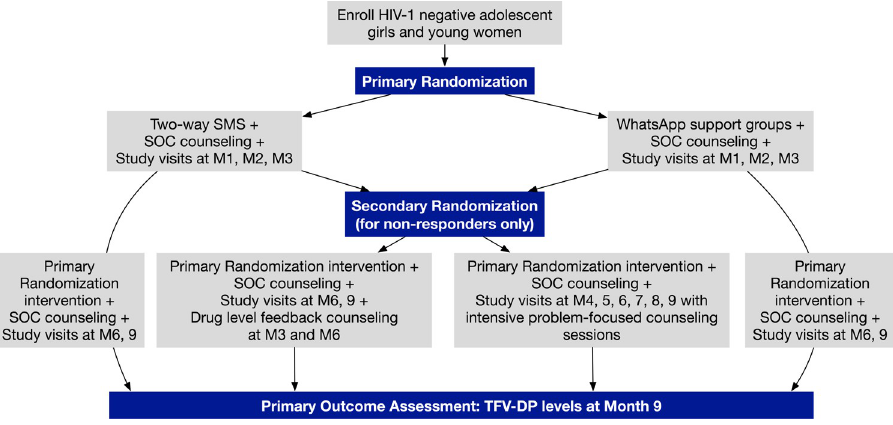
Fig 2. Flow diagram of study enrollment, randomization, and intervention arms. 1 A participant is considered a “non-responder” if they have Month 2 TFV-DP levels < 500 fmol/punch or missed PrEP refills at the Month 1 and/or Month 2 study visits. Secondary randomization takes place at the Month 3 study